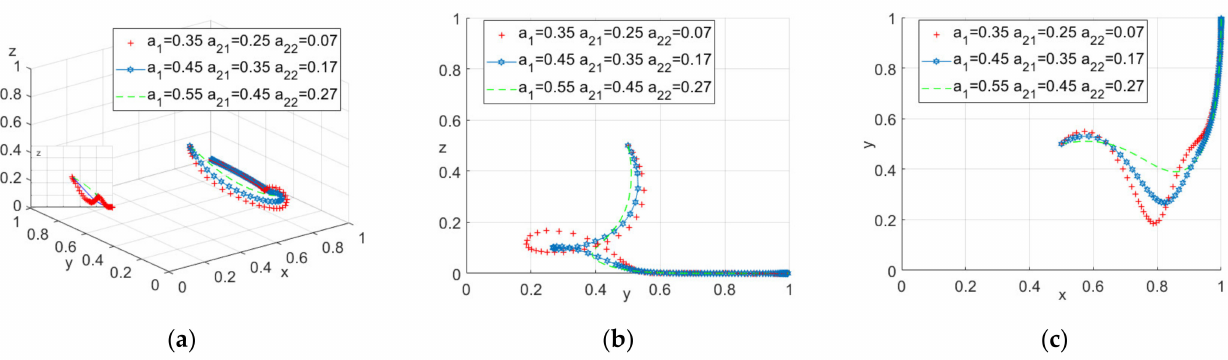
Figure 6. ( a ) Tripartite strategy; ( b ) Government–construction units; ( c ) Construction units–construction